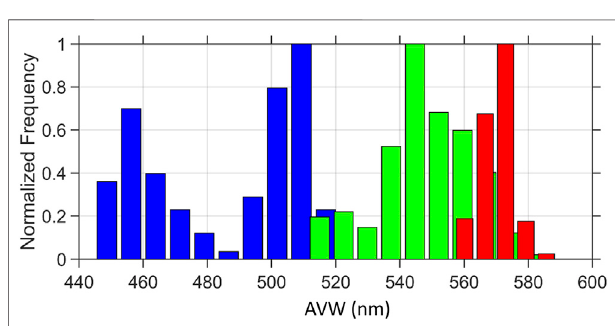
FIGURE7| HistogramofthedistributionofApparentVisibleWavelength (AVW) from Blue-green (blue), Green (green), and Brown (red) water types showing the overlap and general ranges expected for each water type. Ranges from the CASCK-P training data from Figure 4 .